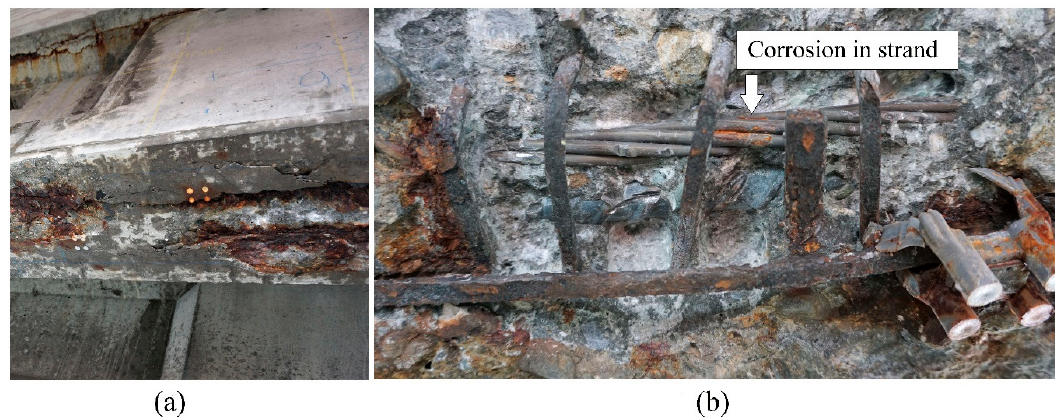
Figure 5. Reinforcement corrosion: ( a ) next to chloride sampling location P2 in Girder 2; ( b ) next to chloride sampling location P1 in Girder 11.